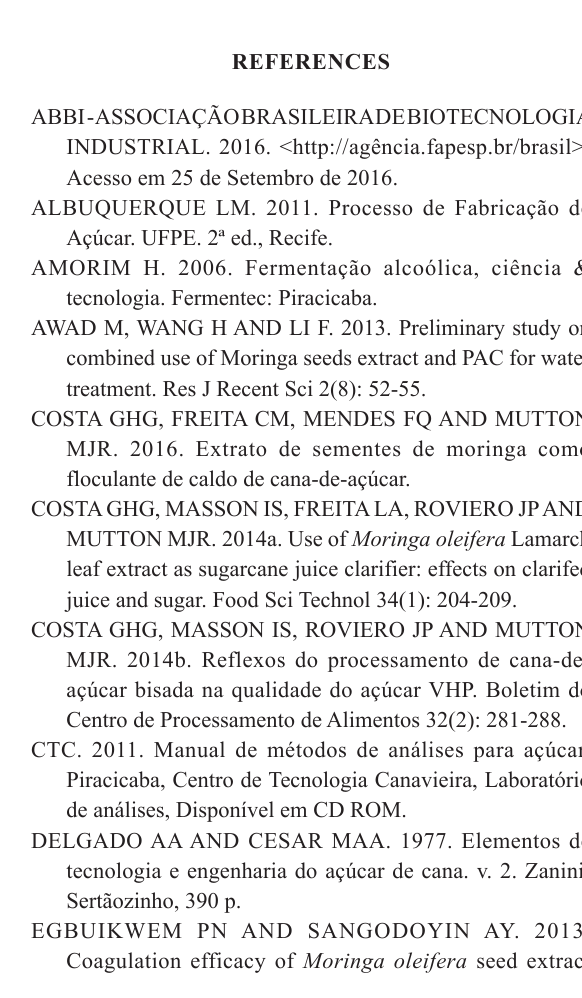
Results for pH, Total Acidity, TRRS, Glycerol, Alcohol Content and Fermentation Efficiency of the wine resulting from the fermentation process using the most prepared from clarified juice with 5 sedimentation aids.